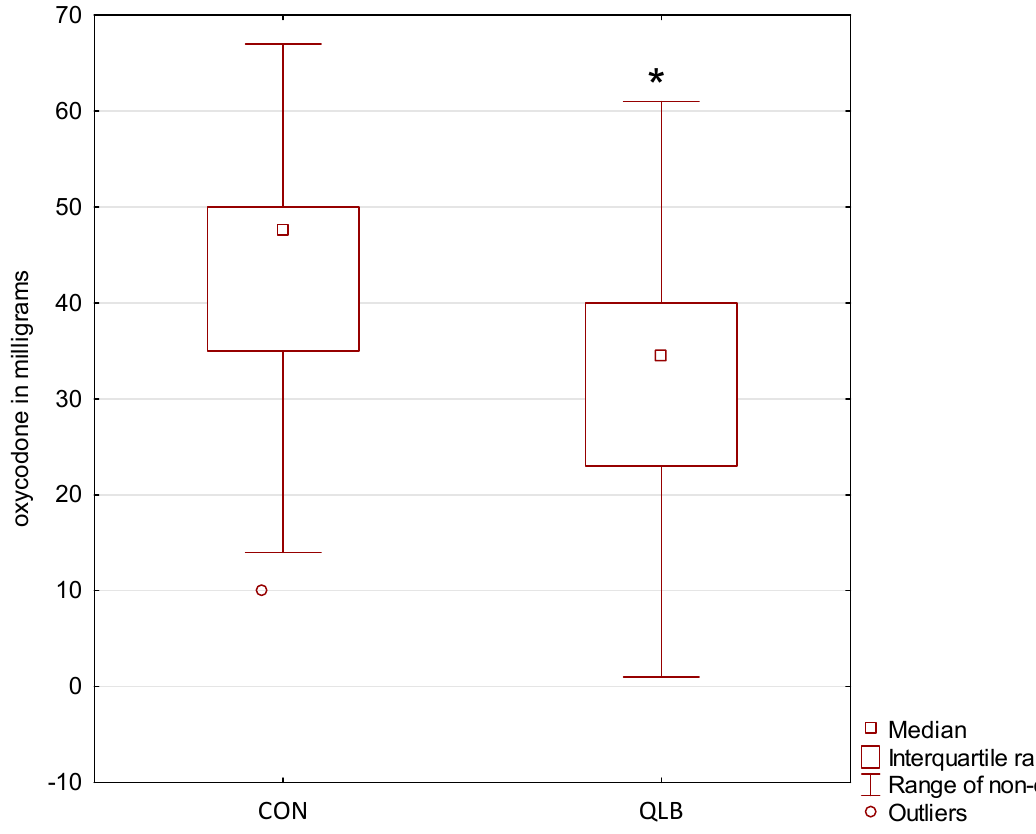
Figure 2. Consumption of oxycodone via patient-controlled analgesia pump during the first 24 postoperative hours; CON: control group; QLB: quadratus lumborum block group; * statistically significant.